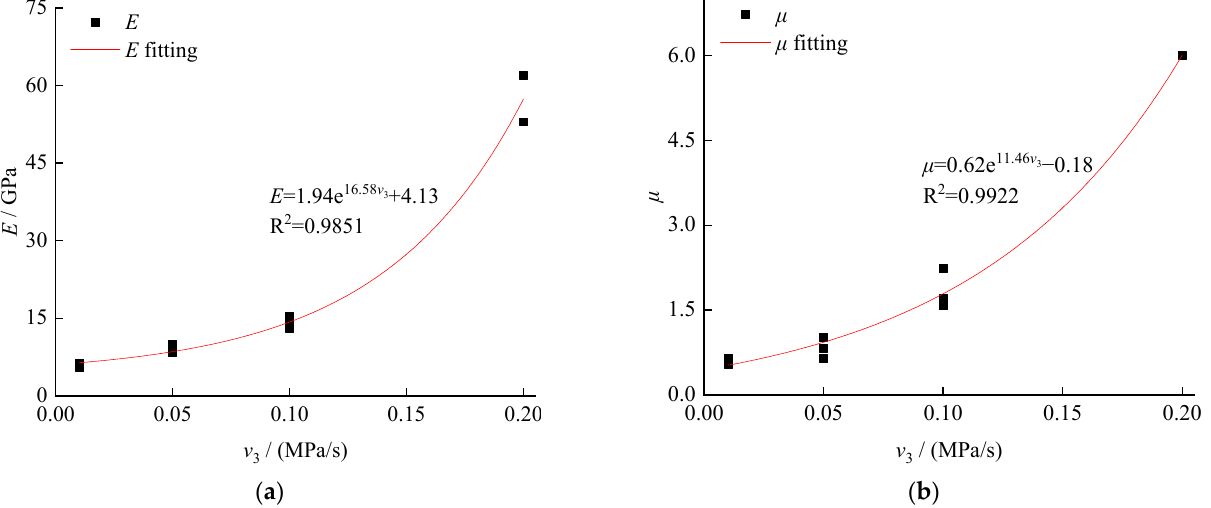
Figure 7. Deformation and unloading rate of the unloading rate of the confining pressure: ( a ) elastic modulus and ( b ) Poisson’s ratio.